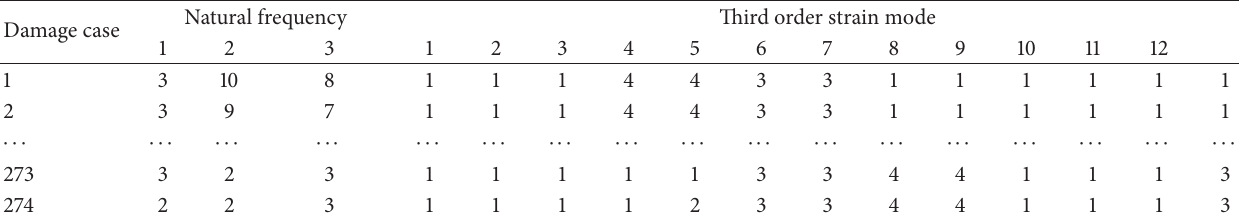
Table 12: Attribute set 3 rules generation for damage position.